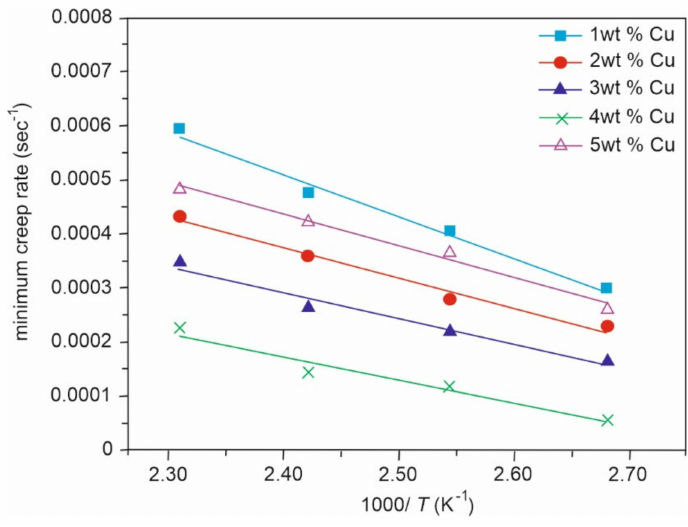
Figure 23. Variation of minimum creep rates with 1000/T, where T is the respective annealing temperature